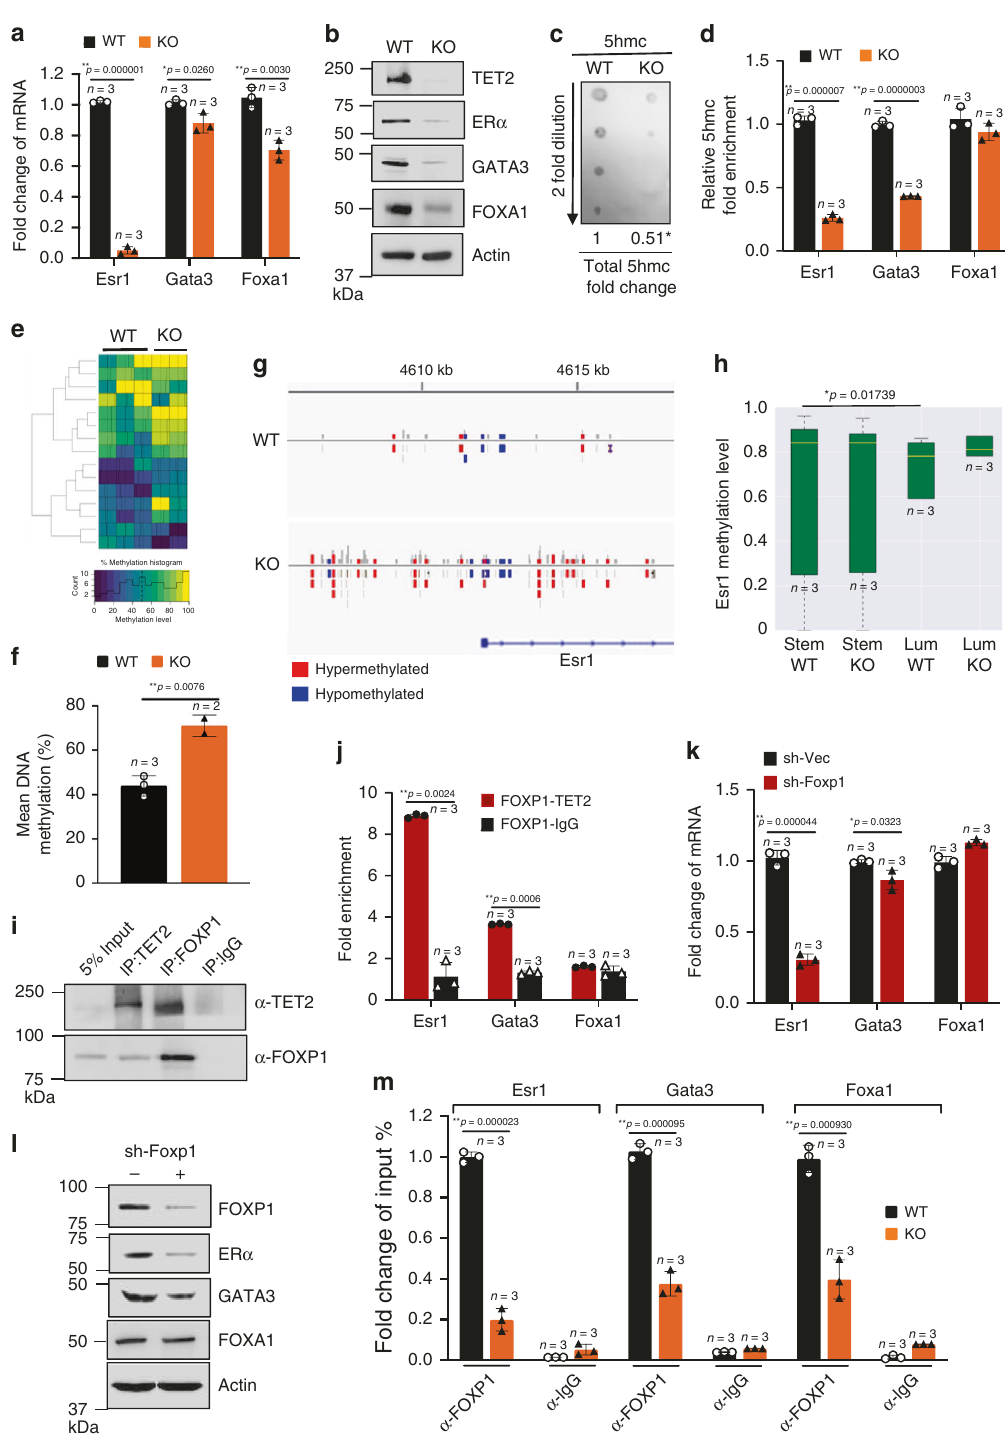
(Fig. 2k,l, Supplementary Fig. 2h). It was shown that TET2 binding to enhancers played a pivotal role for chromatin accessibility and recruitment of transcription factors 30 . Con- cordantly, we showed that deletion of Tet2 abolished FOXP1 recruitment to the Esr1, Gata3 and Foxa1 genes (Fig. 2m, Supplementary Fig. 2i). Together, these data suggest that FOXP1 directs TET2 binding to speci fi c genes ( Esr1, Gata3 , and Foxa1 ), where TET2 is required for FOXP1 chromatin recruitment and coordinately mediates expression of the genes involved in luminal cell